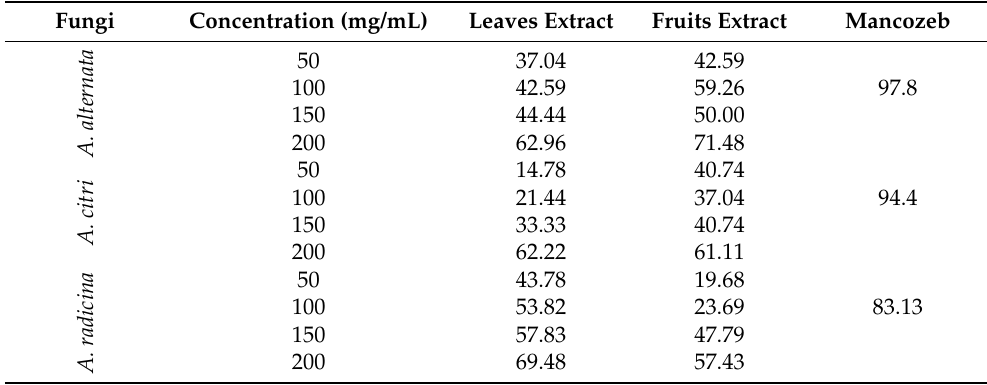
Table 4. The inhibition percentage of leaves and fruits extracts of Zizyphus spina-christi L. against A. alternata , A. citri and A.